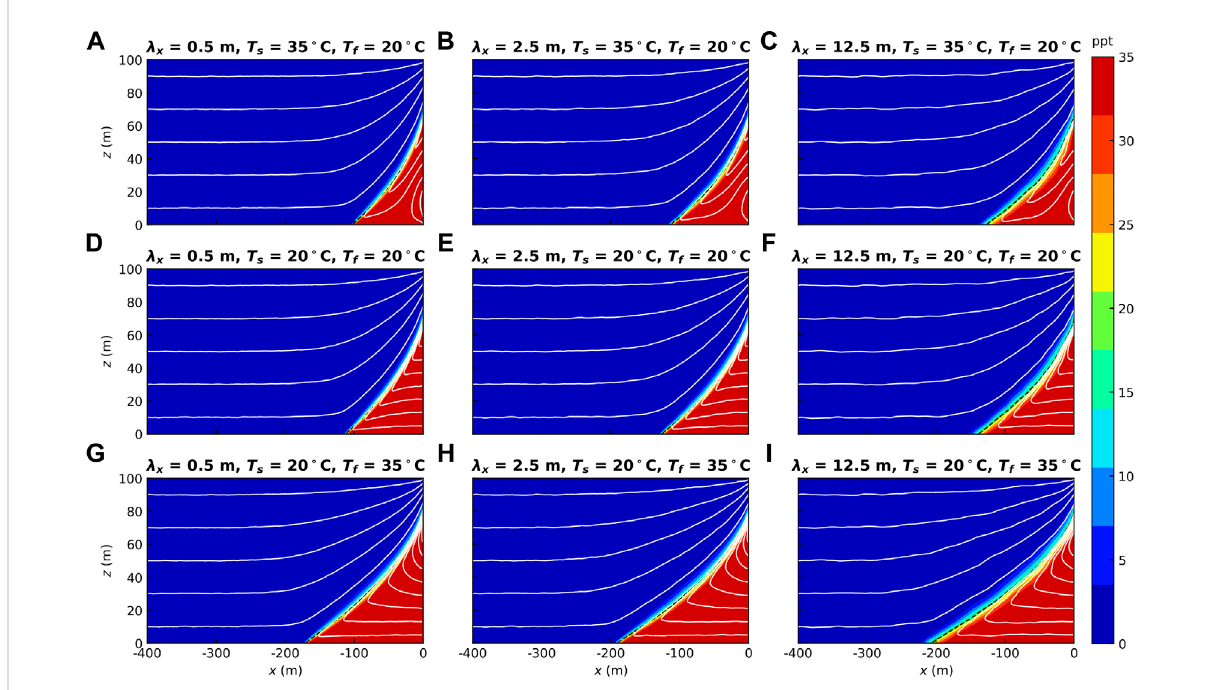
FIGURE 10 Averaged salinity distributions in heterogeneous aquifers under different correlation lengths and FW-SW temperature contrasts ( n = 50). The left-hand (A, D, G) , middle (B, E, H) and right-hand (C, F, I) panels are the results for different correlation lengths of permeability fi elds ( λ x = 0.5, 2.5, and12.5 m,respectively). σ 2 ln k is fi xedat1.Theblackdashedlinesarethe50%seawaterconcentrationisohalines(17.5 ppt),i.e.,theFSI.Thewhitelines show fl ow streamlines. T s and T f are seawater and freshwater temperatures,